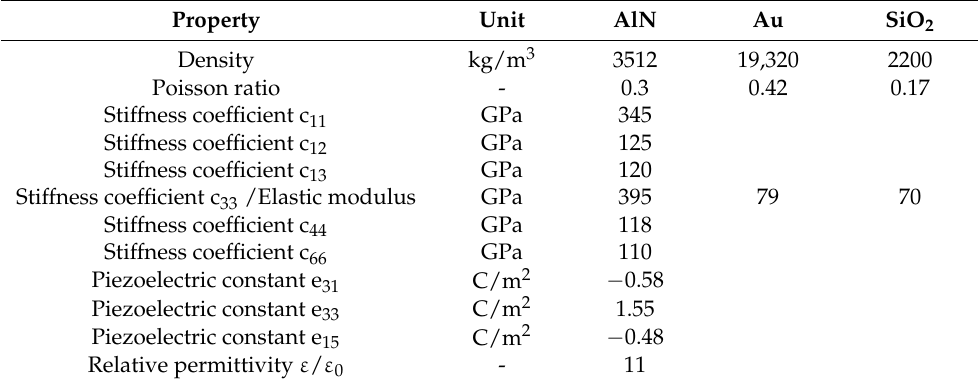
Table 2. Used material parameters. AlN: aluminum nitride, Au: gold, SiO 2 : silicon dioxide. Property Unit AlN Au SiO 2 Density kg/m 3 3512 19,320 2200 Poisson ratio - 0.3 0.42 0.17 Stiffness coefficient c 11 GPa 345 Stiffness coefficient c 12 GPa 125 Stiffness coefficient c 13 GPa 120 Stiffness coefficient c 33 /Elastic modulus GPa 395 79 70 Stiffness coefficient c 44 GPa 118 Stiffness coefficient c 66 GPa 110 Piezoelectric constant e 31 C/m 2 − 0.58 Piezoelectric constant e 33 C/m 2 1.55 Piezoelectric constant e 15 C/m 2 − 0.48 Relative permittivity ε / ε 0 -